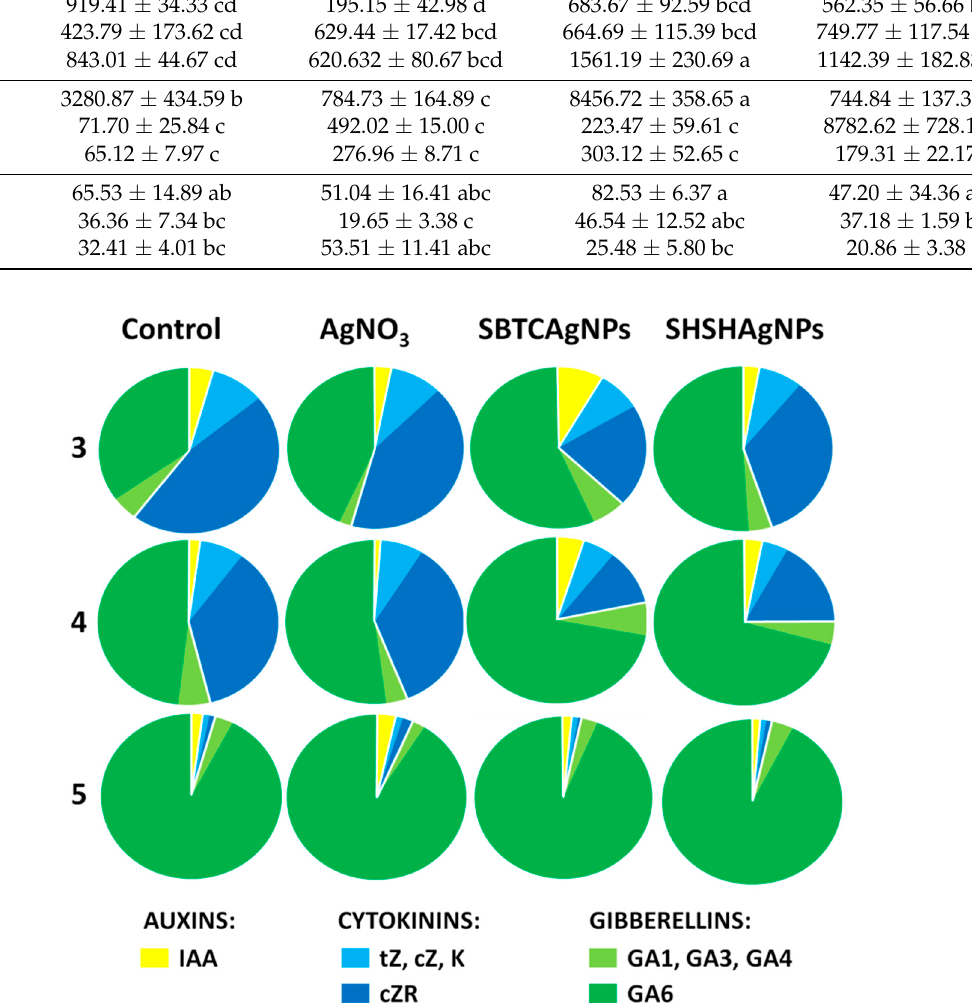
Figure 2. Proportions between three main group of phytohormones of the control and the AgNO 3 , SBTCAgNPs and SHSHAgNPs treated wheat plants from the 3rd to 5th week of growth. Table 1. Endogenous phytohormone content (ng/g DW) in the leaves of the control and the AgNO 3 -, SBTCAgNPs- and SHSHAgNPs-treated wheat plants after 3, 4 and 5 weeks of growth. The presented data are the mean values based on 5 replicates ± SE. The mean values marked with the same letter within a parameter (phytohormone) did not differ significantly according to Duncan’s test, where p ≤ 0.05 (nd—not detected).